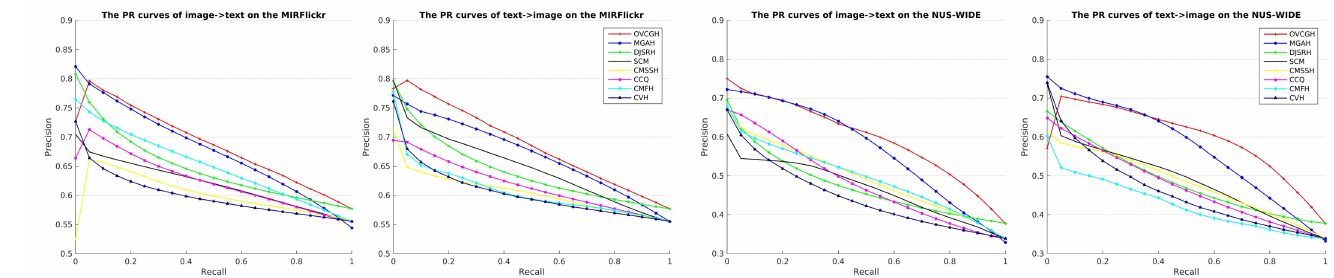
Figure 3. The PR curves on the MIRFlickr and NUS-WIDE datasets with 16-bit hash